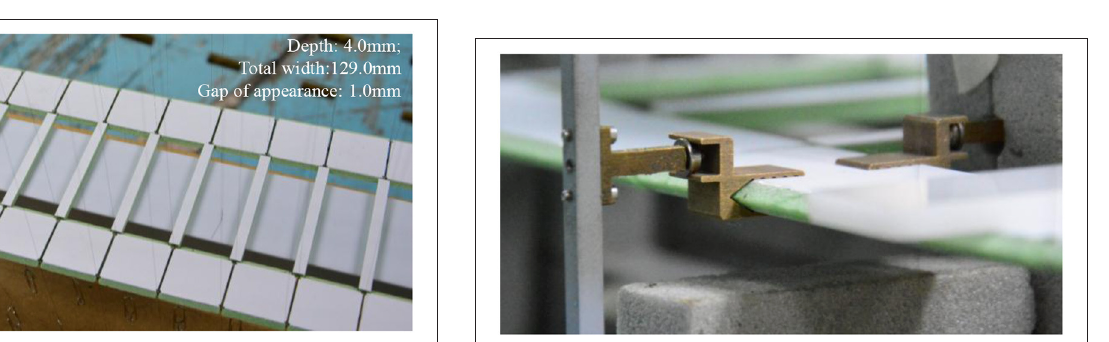
FIGURE 7 | Appearance of stiffening girder.